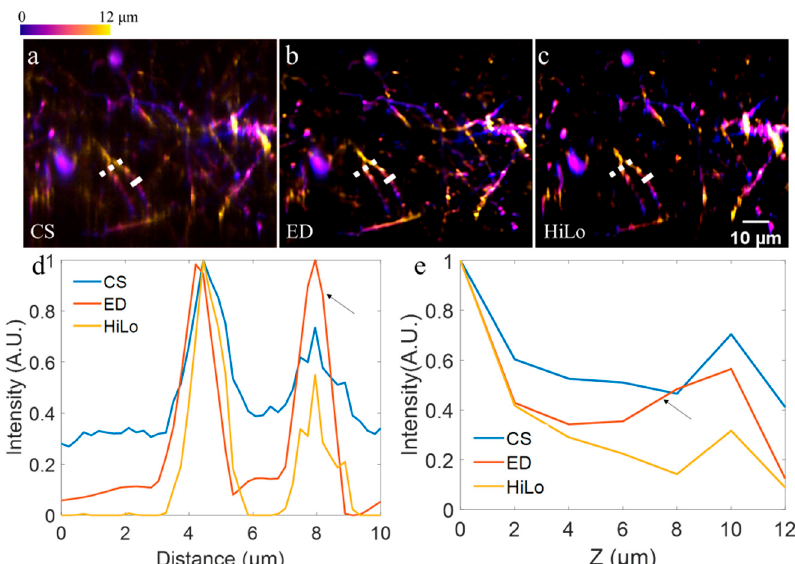
Figure 3. Volumetric imaging of neurons in Thy1-YFP mouse brains. ( a – c ) Color-coded axial stack based on virtual confocal slit detection (CS), extended detection (ED), and our proposed method here (HiLo), respectively. ( d ) Profiles along dotted lines in ( a – c ), with each profile being normalized. ( e ) Gaussian-fitted peak intensity along solid lines in ( a – c ) versus axial plane.